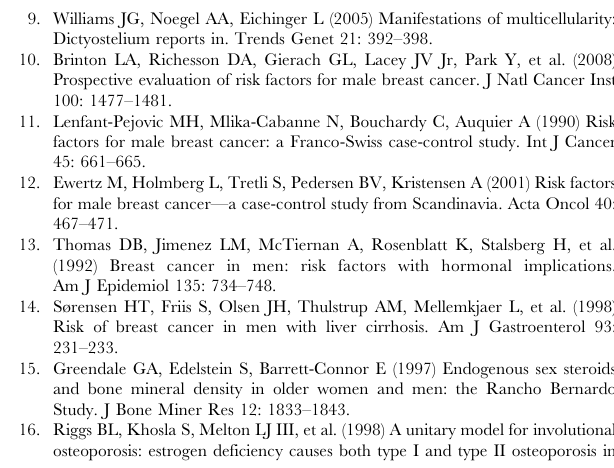
Figure S7 Male multi-diet comparison pathways. Significantly altered pathways in the testes of the male rats placed on each of the four experimental diets (20% CR, 40% CR, IF, or HFG) were